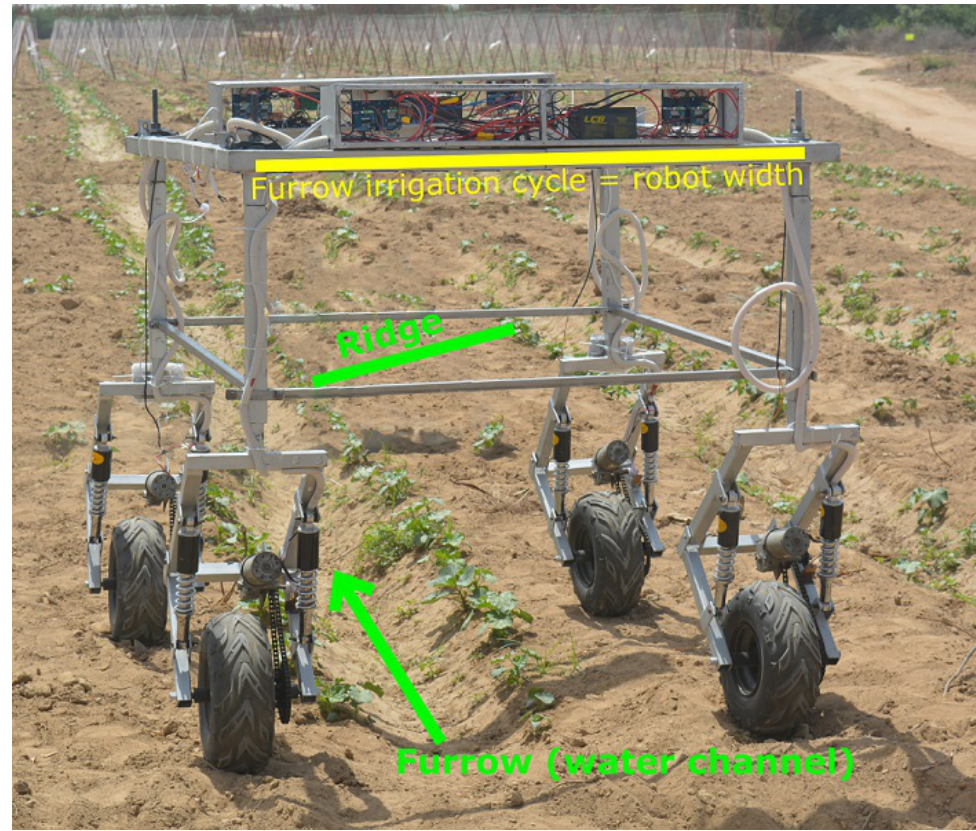
Figure 8. Weed robot dimensions in relation with field